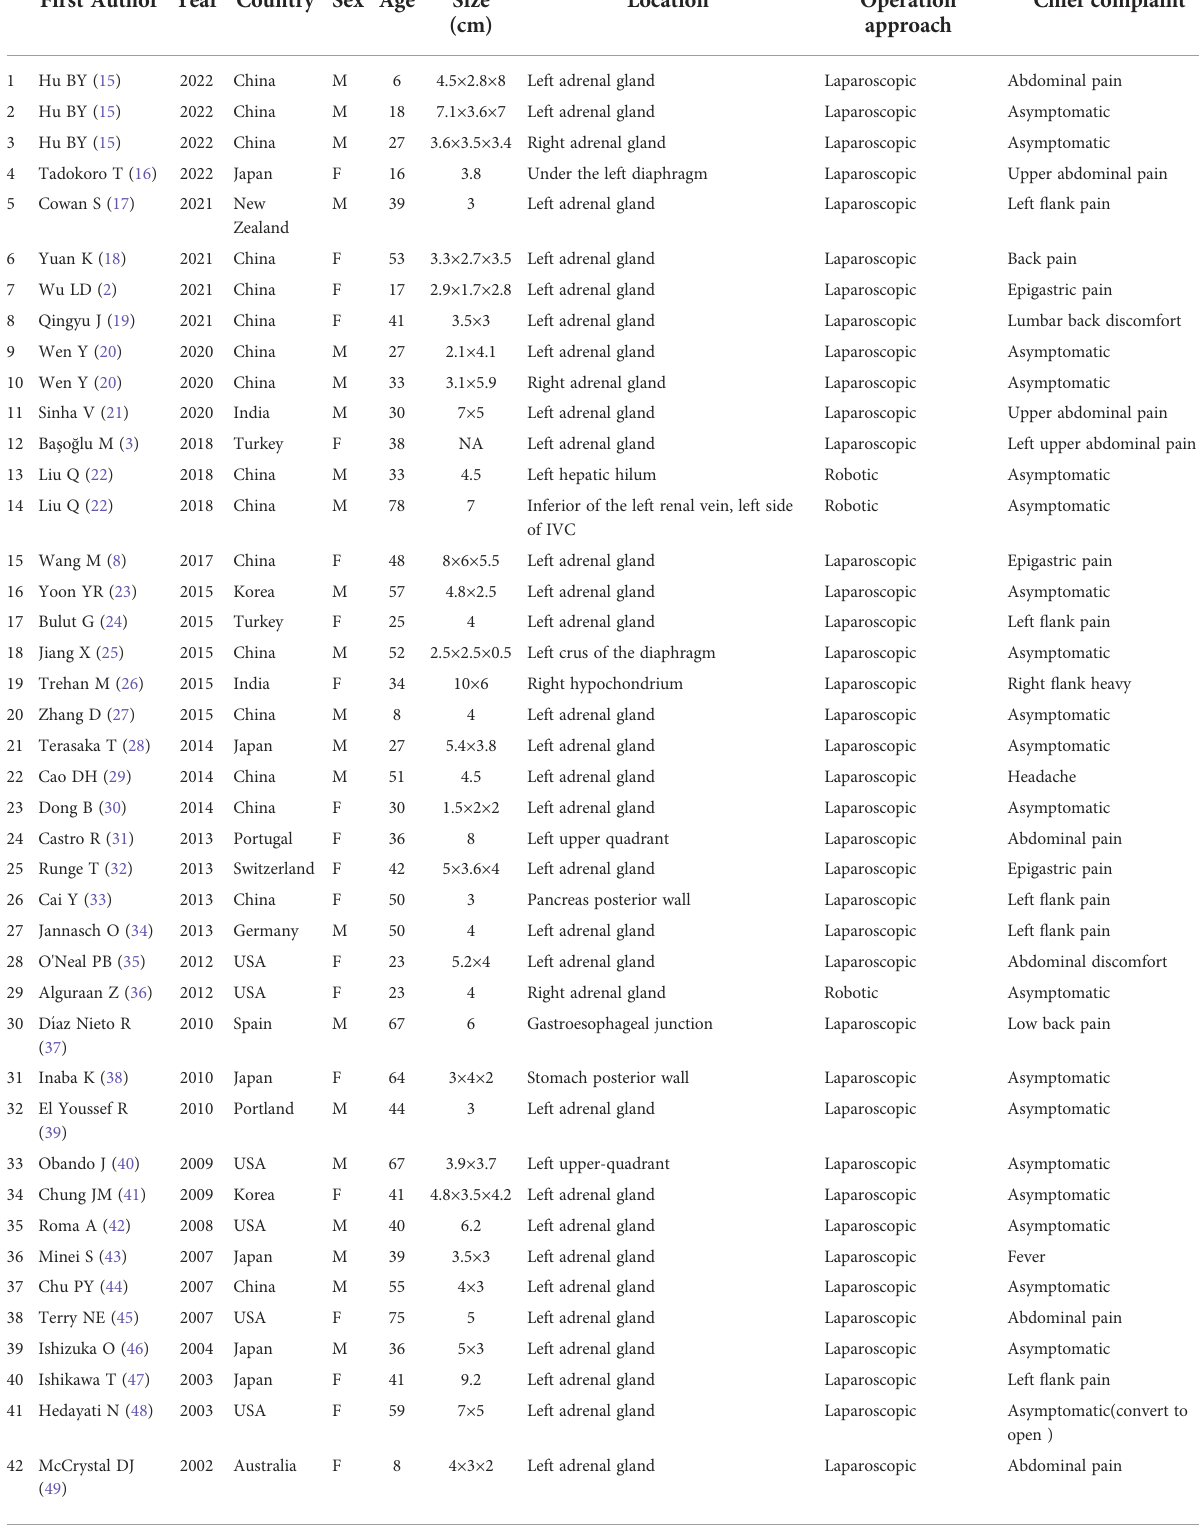
Table 2 Literature review of retroperitoneal bronchogenic cyst undergoing laparoscopic surgery. First Author Year Country Sex